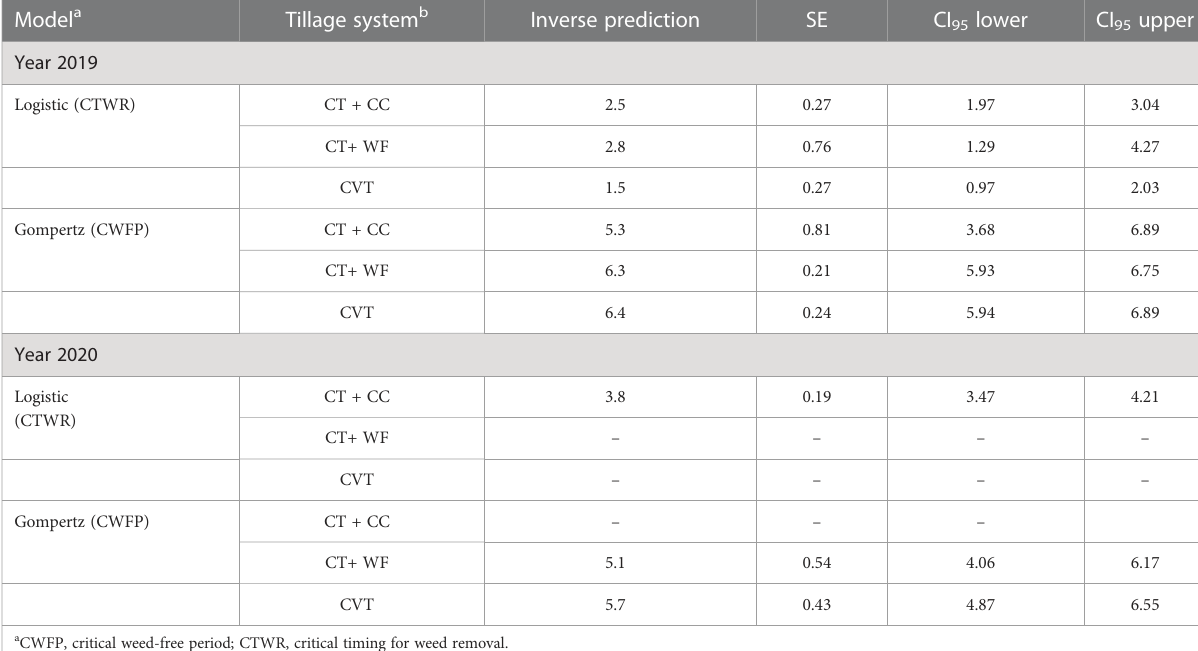
TABLE 1 The estimation of points (i.e., inverse predictions), standard errors (SE) of inverse predictions, and con fi dence intervals (CI 95 ) corresponding to a 5% acceptable yield loss for the Logistic and Gompertz models used to estimate the beginning and end of the critical period in 2019 and 2020 for weed control in corn under three different tillage systems.